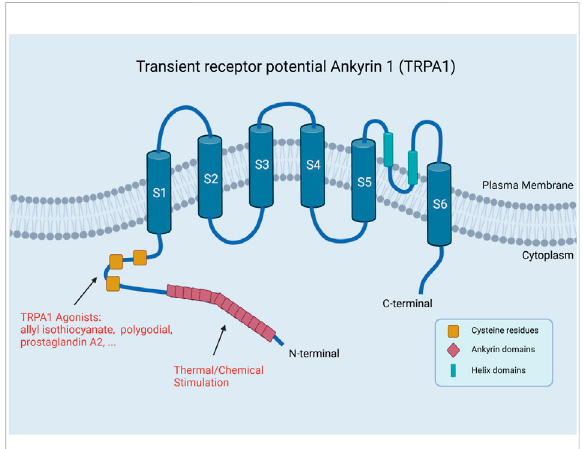
FIGURE 1 Structure of TRPA1. TRPA1 has a long N-terminal ankyrin domain, which is composed of multiple ankyrin repeats, mainly including the regions responsible for the interaction with other proteins and reception of external stimuli by the channel, such as thermal and chemical stimulation (Created with